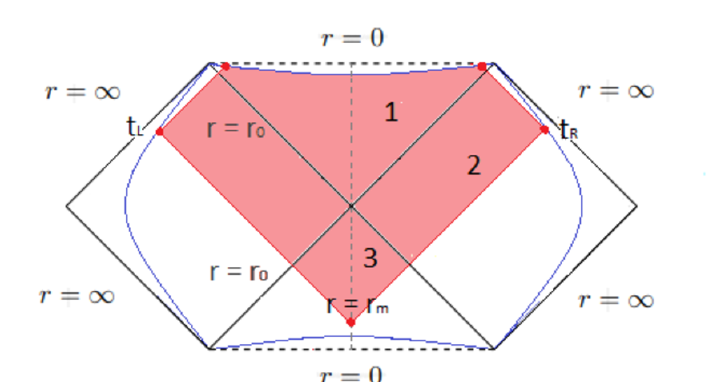
Figure 3 . Penrose diagram for the non-rotating BH, with the WDW patch for t b > t C